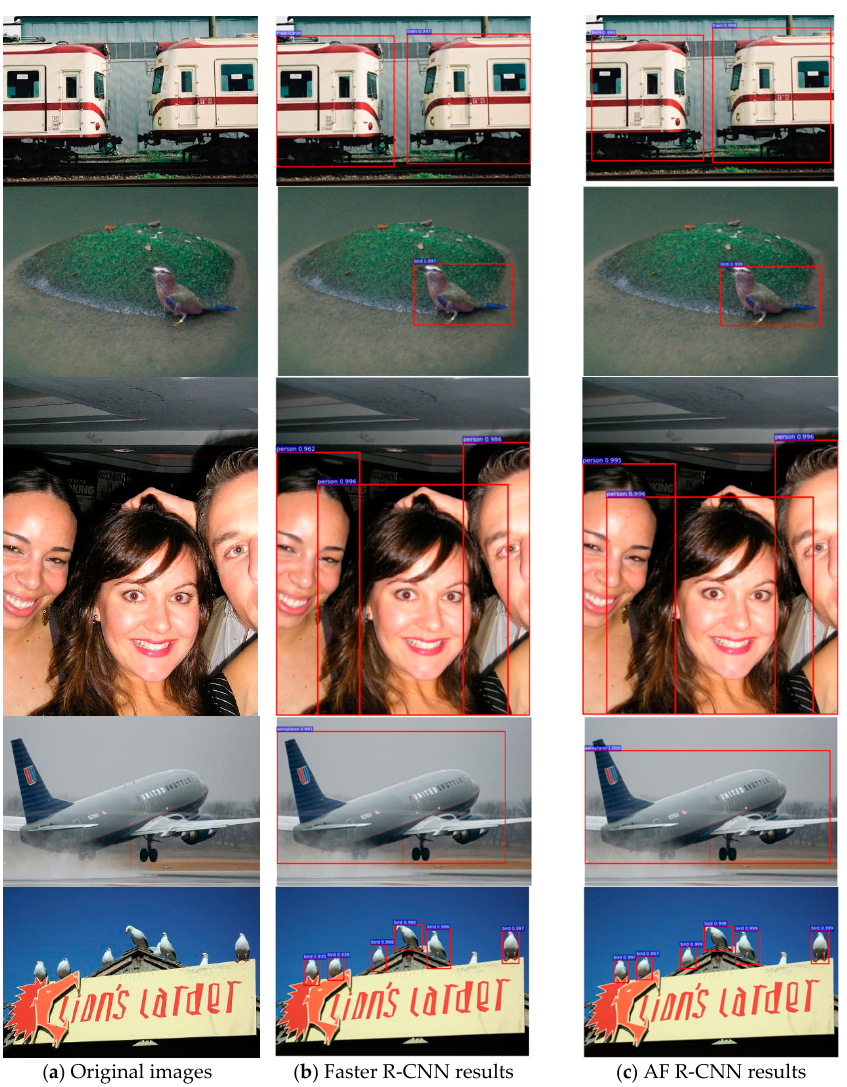
Figure 7. Results of object detection. ( a ) shows the input images of the object detection networks; ( b ) shows the visualization of the detection results of the Faster R-CNN; ( c ) shows the visualization of the detection results of the AF